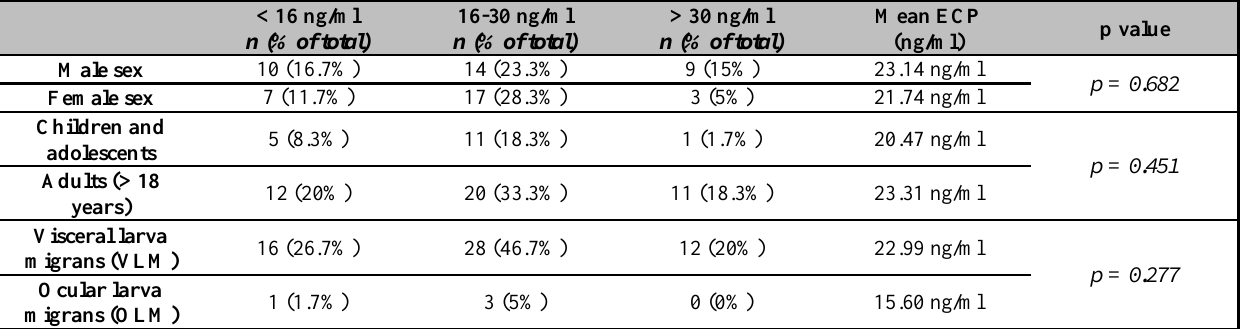
Table 1. Serum ECP levels in patients with toxcariasis by sex, age and clinical form of